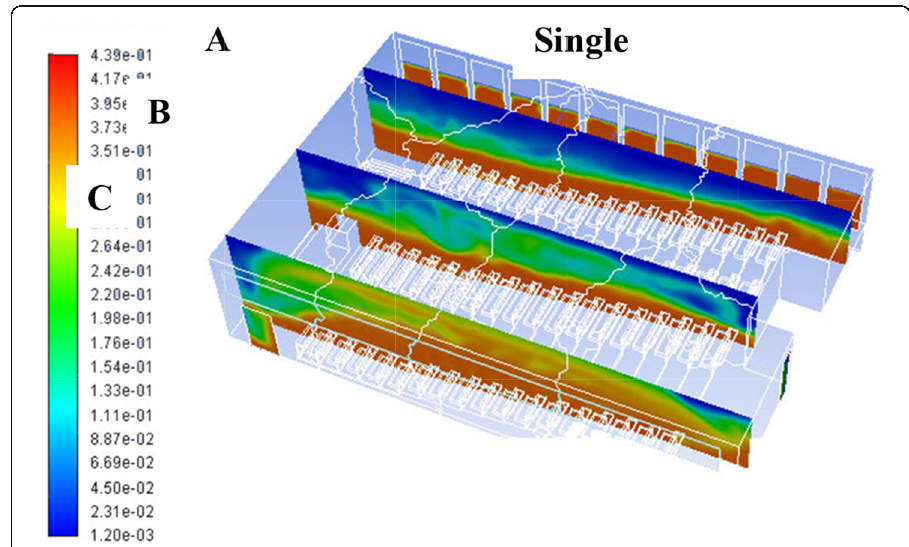
Fig. 5 3D model for the contours of CO 2 concentrations (Mole fraction) at A , B , and C sections (source: the